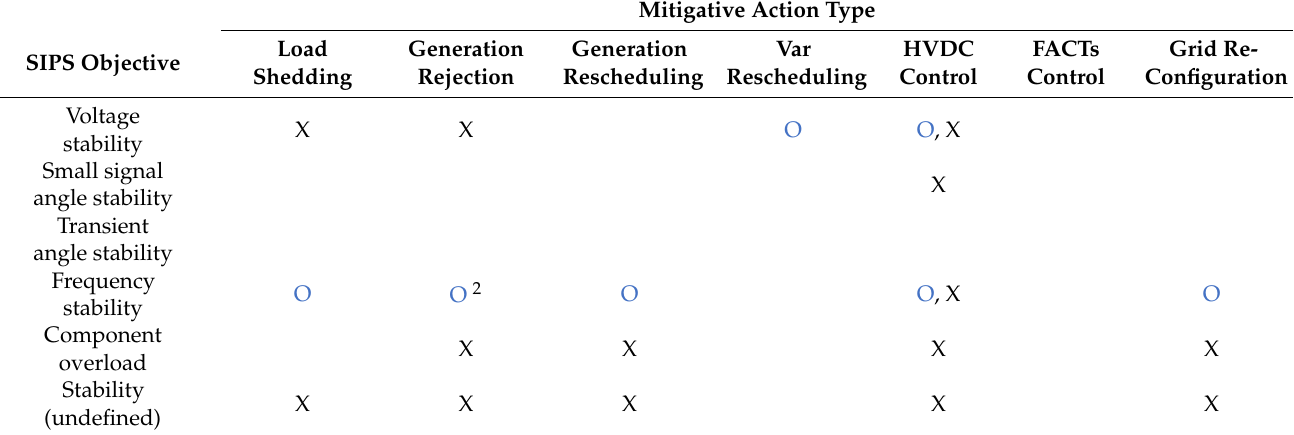
Table 4. Classification of SIPS 1 integrated in the Nordic power system, based on information available in